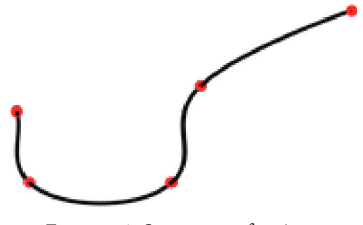
Figure 6: Sequence of points.